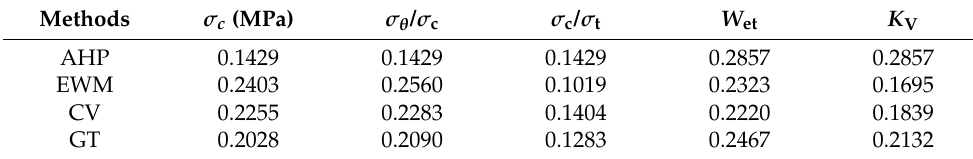
Table 4. The weights of each indicator of rockburst intensity.